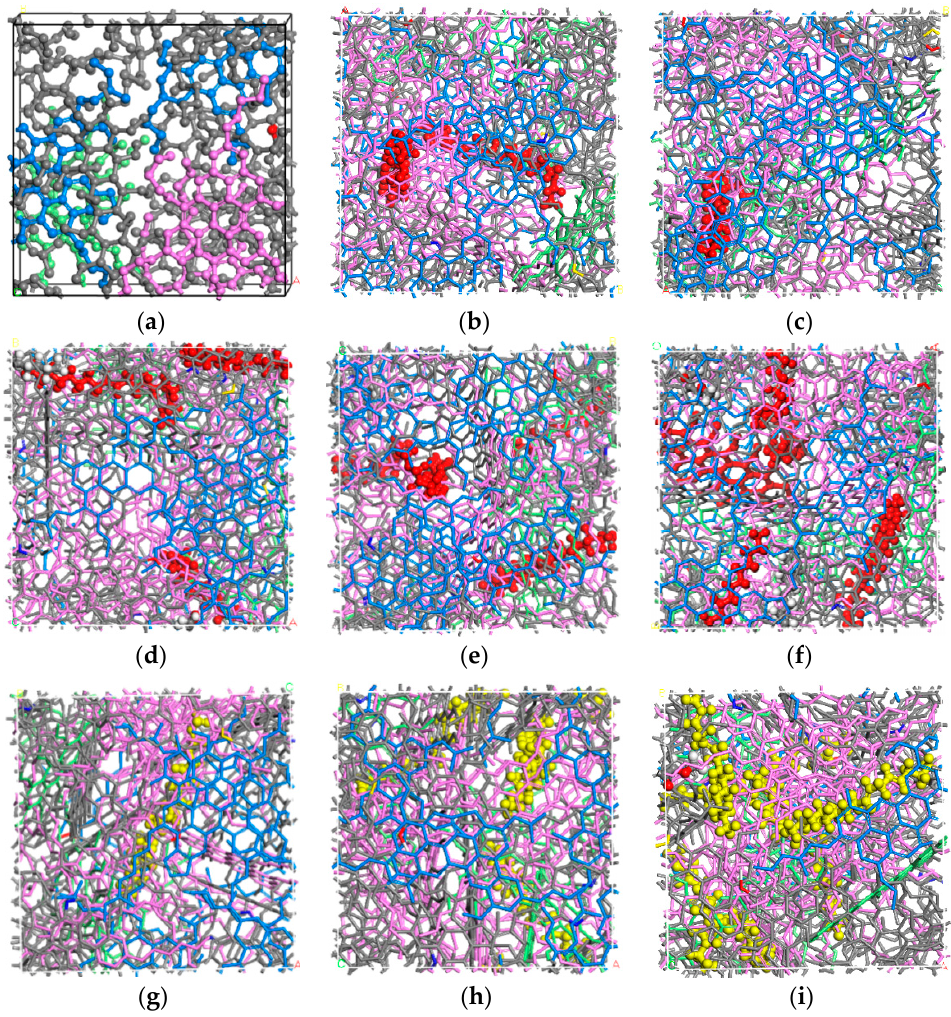
Figure 2. ( a ) A-70# base asphalt binder; ( b – f ) 1~5% C 18 H 32 O 2 , red components; and ( g – i ) 1 ∼ 3% C 18 H 34 O 2 , yellow components.